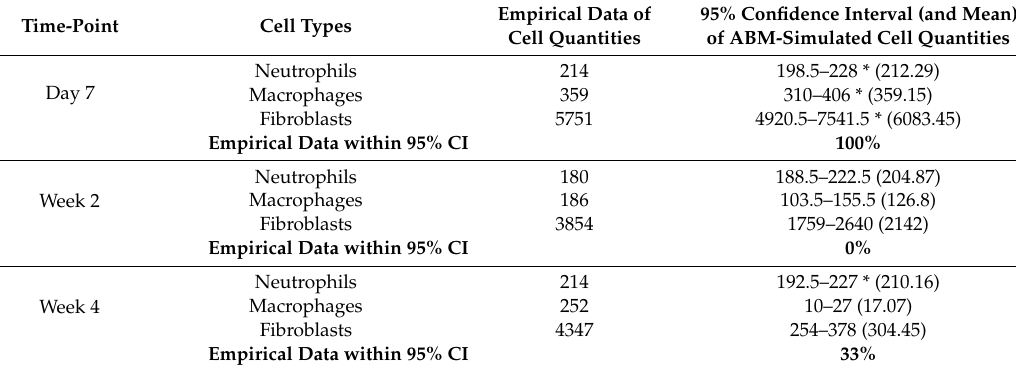
Table 6. Cell quantities from empirial and simulation experiments from Day 7 to Week 4. * denotes the empirical data within the 95% confidence interval (CI) of VF-ABM